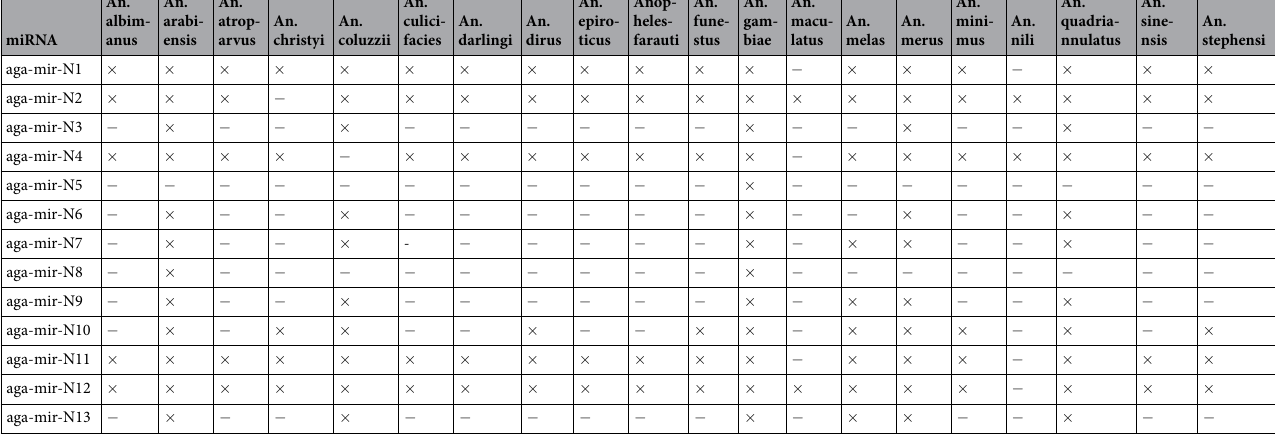
Table 2. Conservation of novel miRNAs in 20 Anopheles species. Note: “ × ” indicates that the miRNA orthologue is found by reciprocal blast; “ − ” means no